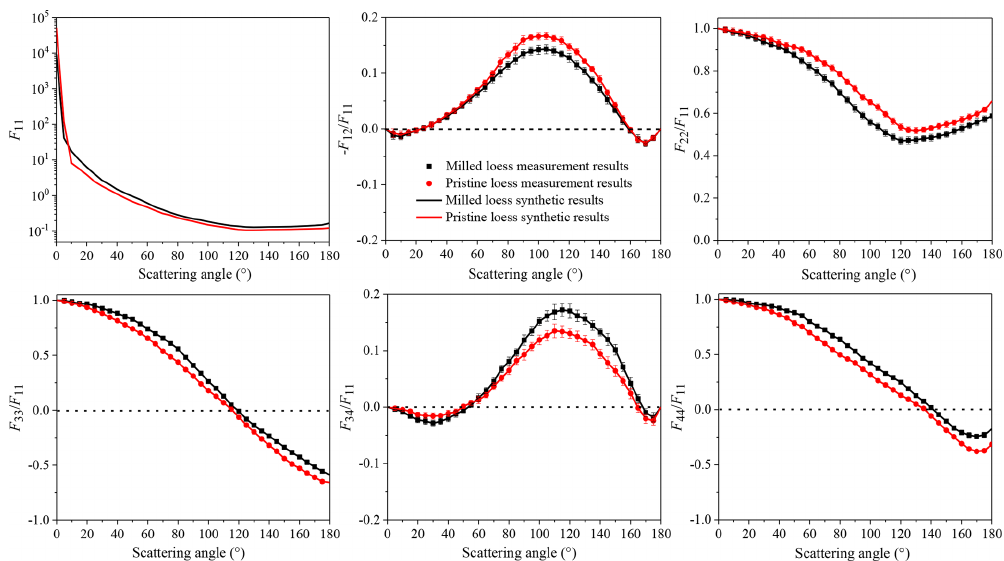
Figure 5. Synthetic scattering matrices for milled loess and pristine loess. Lines are synthetic matrices, and plots are measured values.